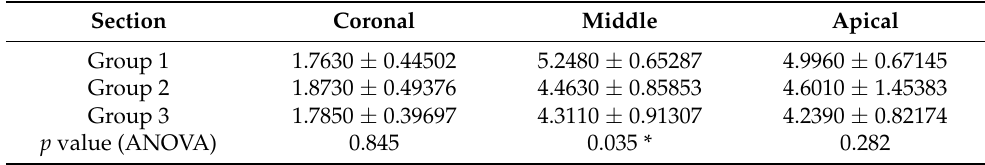
Table 1. The mean, standard deviation, and statistical values of one-way ANOVA compared between the three groups (Group 1: sodium hypochlorite and saline; Group 2: Arnica montana ; and Group 3: chlorhexidine). Section Coronal Middle Apical Group